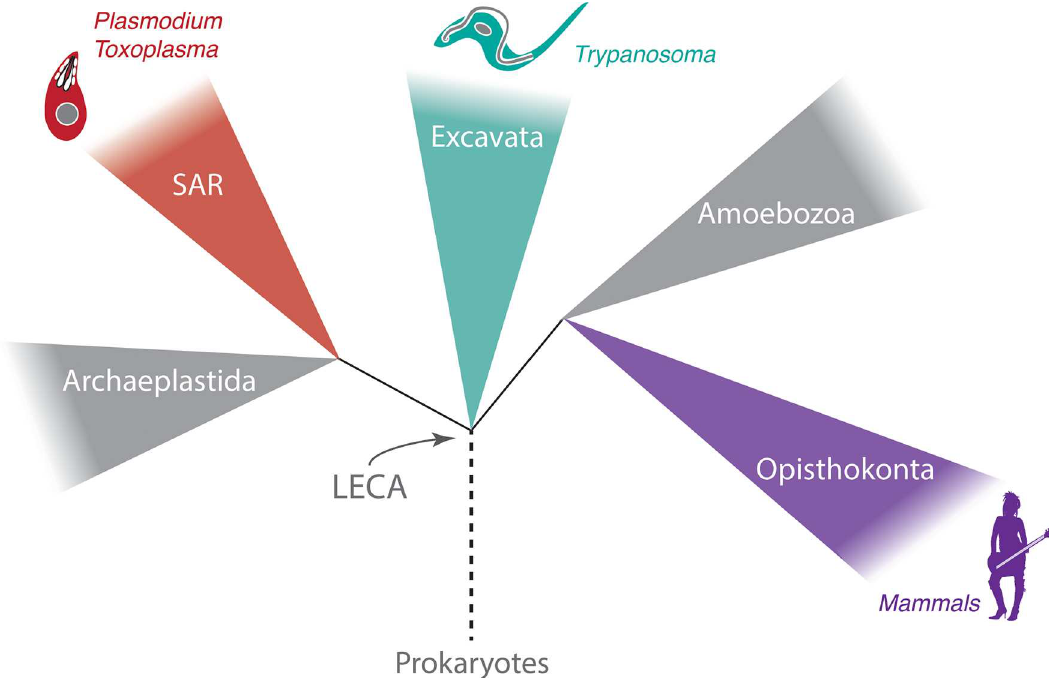
Fig 1. Overview of eukaryotic phylogeny emphasising the supergroup affiliation of organisms discussed here. Each of five recognised eukaryoticsupergroupsis shown as a coloured triangleto indicate that it containsa great many lineages, which are under continualdiversification; groupsnot discussedare in gray, whilst Excavata (teal), stramenopiles, alveolates, and Rhizaria(SAR, red), and Opisthokonta (purple)are shown with icons for representative organisms. All of these groups radiatedrapidly followingthe origin of eukaryotes and evolutionof the LECA. Relationships are basedon recent views of the branching order but shouldnot be considered